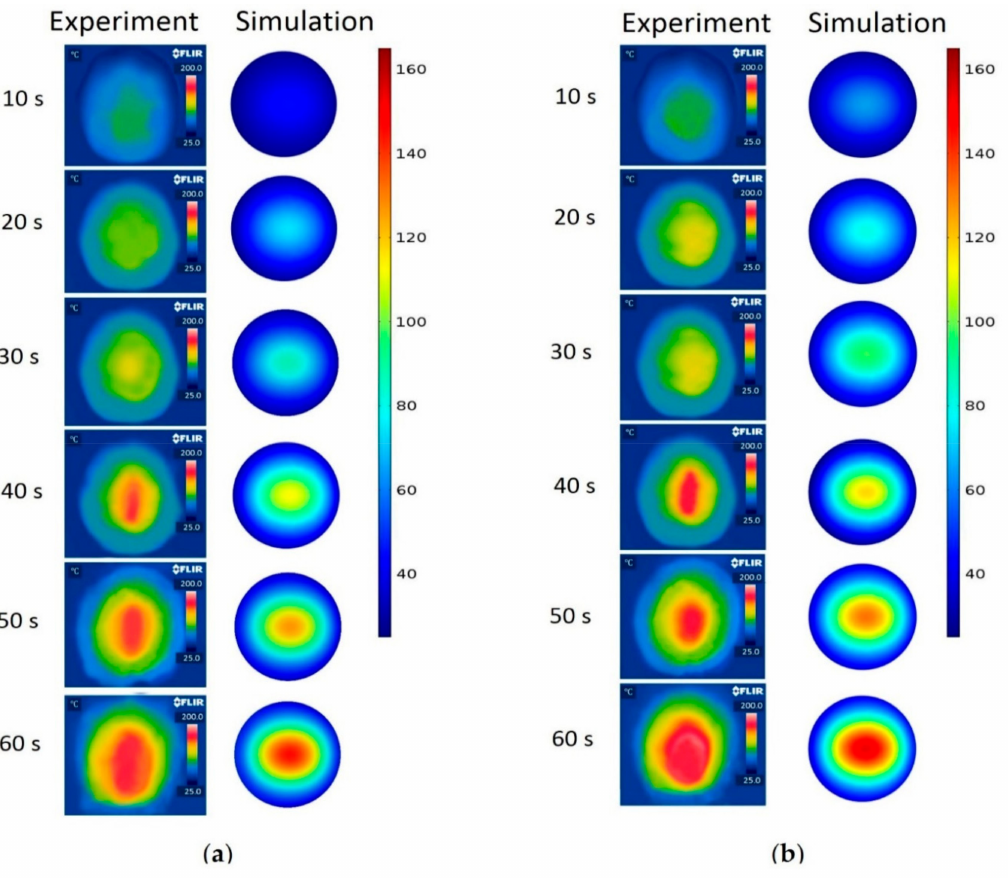
Figure 10. Comparison between infrared thermal image and simulation model of temperature distributions; ( a ) unripe banana; ( b ) ripe